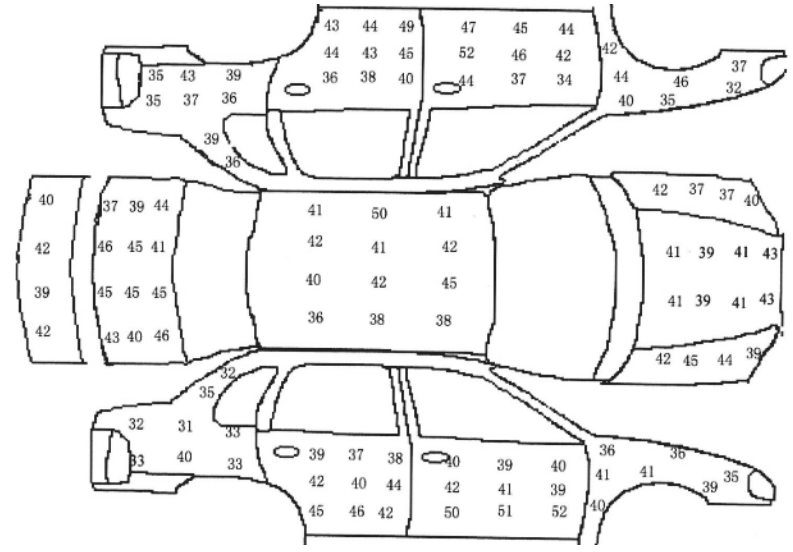
Figure 12. Paint thickness at the sampling points on the automobile body.